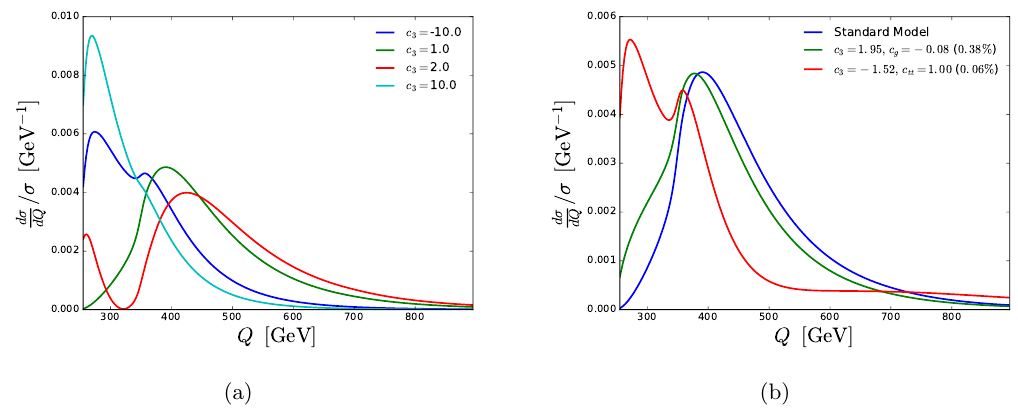
Figure 4 . Invariant mass distribution of the produced Higgs boson pair plotted for (a) di(cid:11)erent values of its self-coupling, and (b) di(cid:11)erent combinations of anomalous couplings that are degenerate with the SM. The relative deviation from the SM of the total cross section in (b) is speci(cid:12)ed between brackets on the